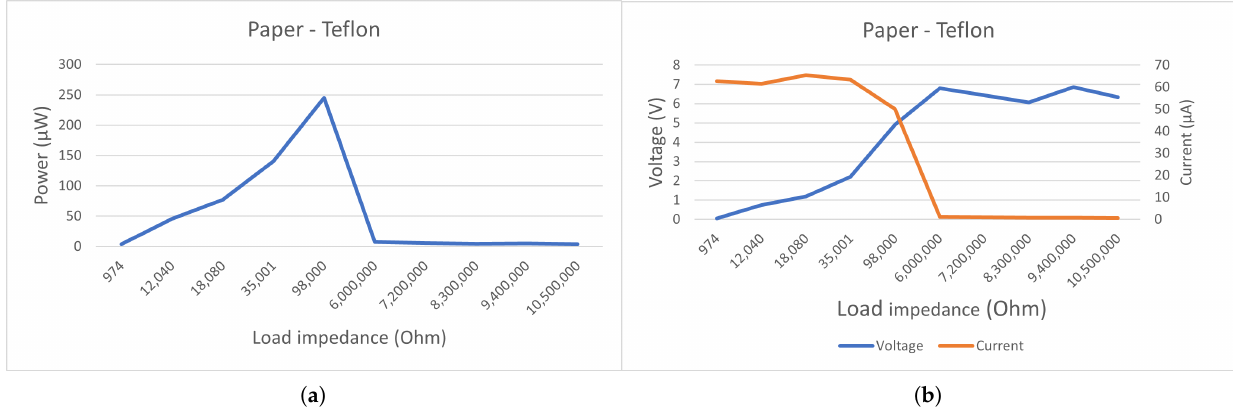
Figure 4. Electrical characterization of a triboelectric nanogenerator (TENG) with a resistive load. Converted power versus load resistance ( a ). The TENG’s peak current/voltage ( b